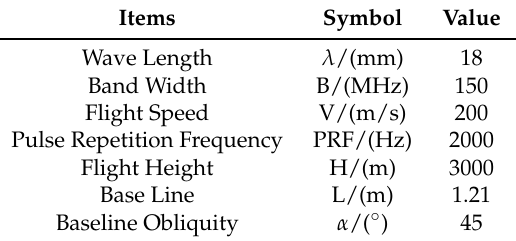
Figure 4. Simulation scene information. ( a ) Simulation Scene ( b ) Preset DEM ( c ) Interferometric phase without RME ( d ) Coherence map without RME. Table 1. Parameters of simulate InSAR